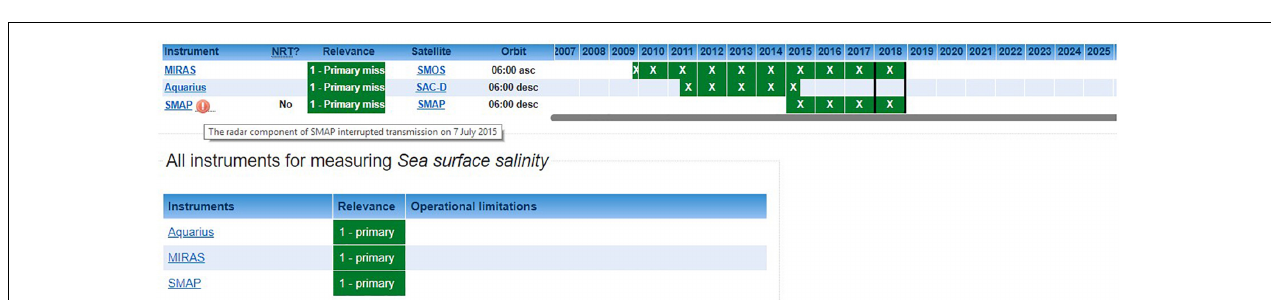
FIGURE 6 | OSCAR/Surface screen shots showing graphical maps showing platforms/stations for which metadata are available via mouse click (land/sea surface in blue, sub-surface in green).